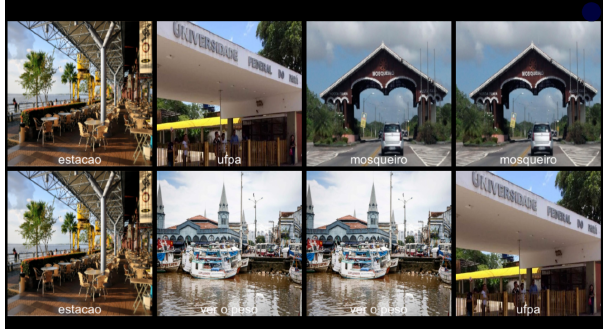
Figure 6. Custom Themed Match Screen